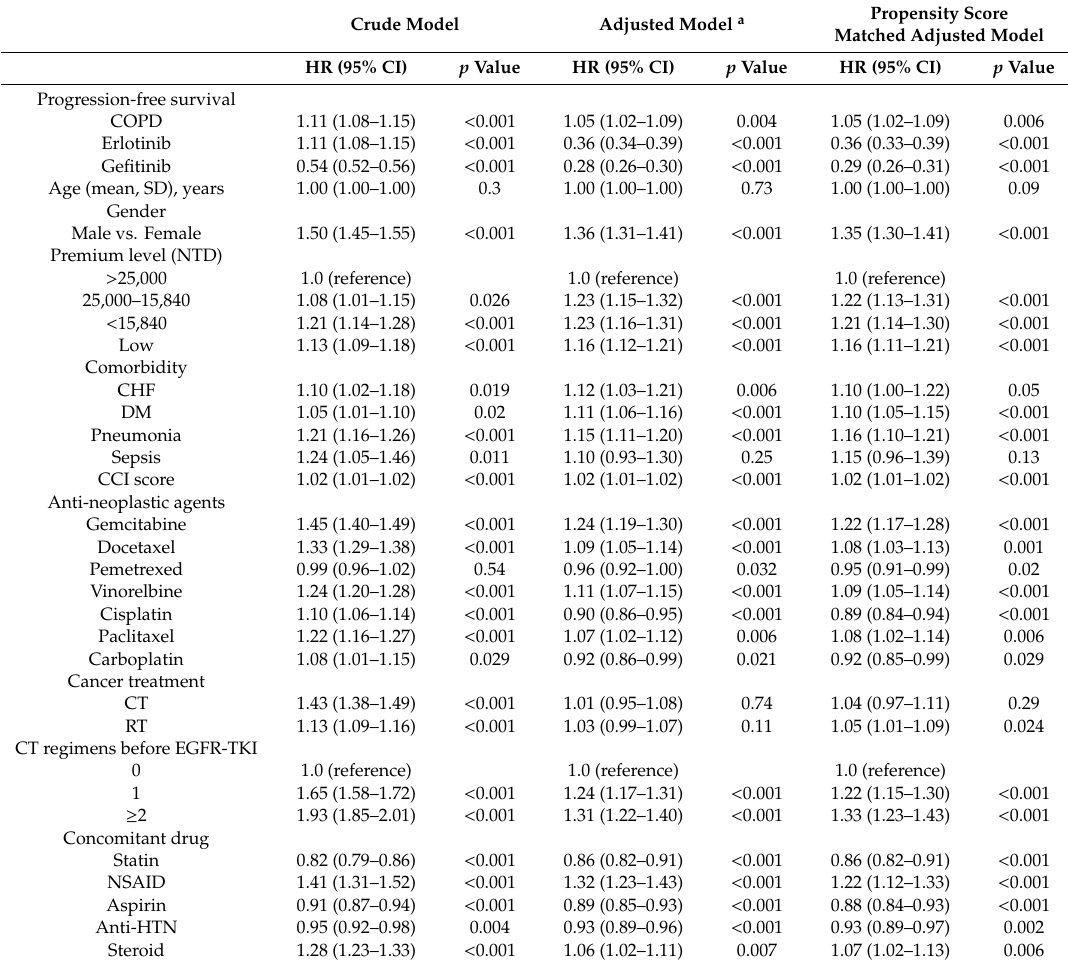
Table 3. Comparison of HRs of progression-free survival for all